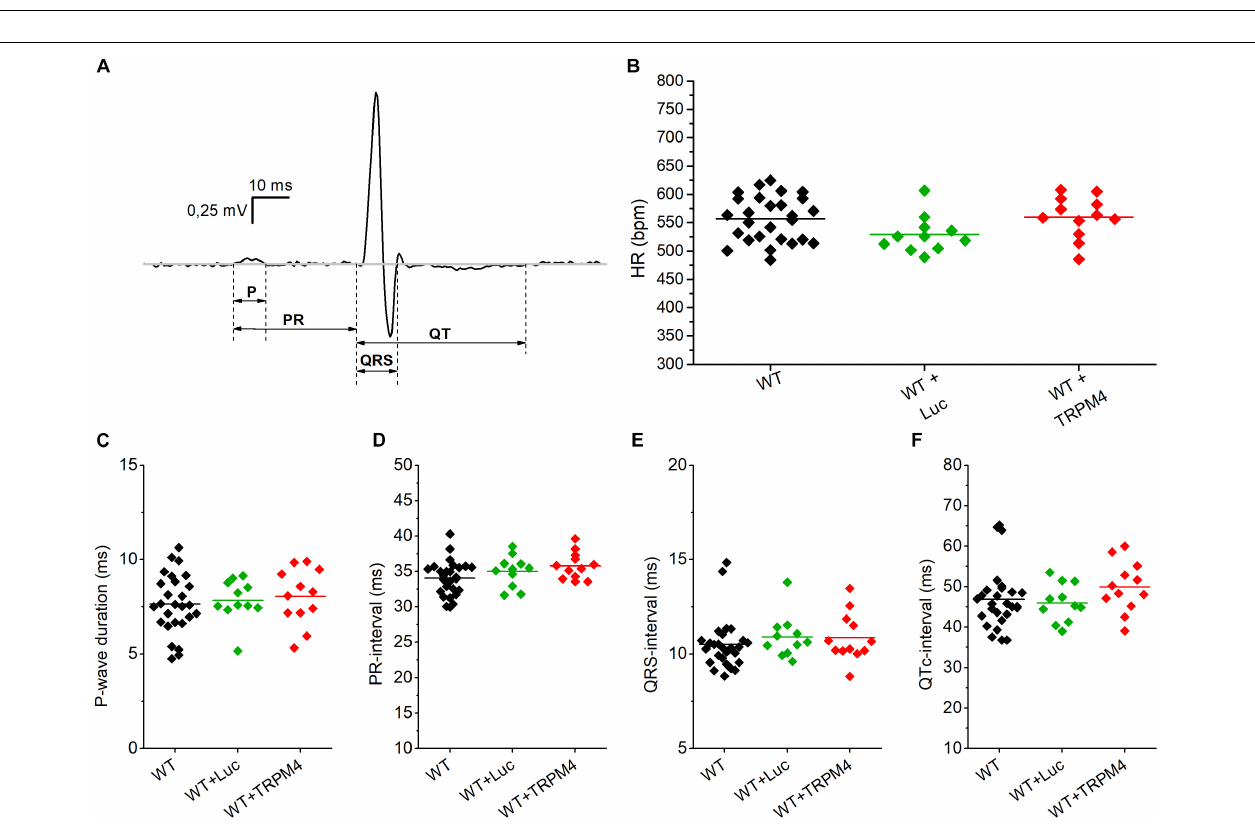
FIGURE 4 | Conduction parameters in freely moving WT, WT+Luc, and WT+TRPM4 mice (WT: n = 27, WT+Luc: n = 11, WT+TRPM4: n = 12). (A) Representative ECG-trace with indicated conduction intervals. (B–F) Comparison of heart rate (B) , P-wave duration (C) , PR-interval (D) , QRS-interval (E), and corrected QT-interval (F) between awake WT, WT+Luc, and WT+TRPM4 mice (One-way ANOVA: HR and p-wave duration; Kruskall–Wallis ANOVA followed by a Dunn’s post test: PR-, QRS-, QTc-interval).